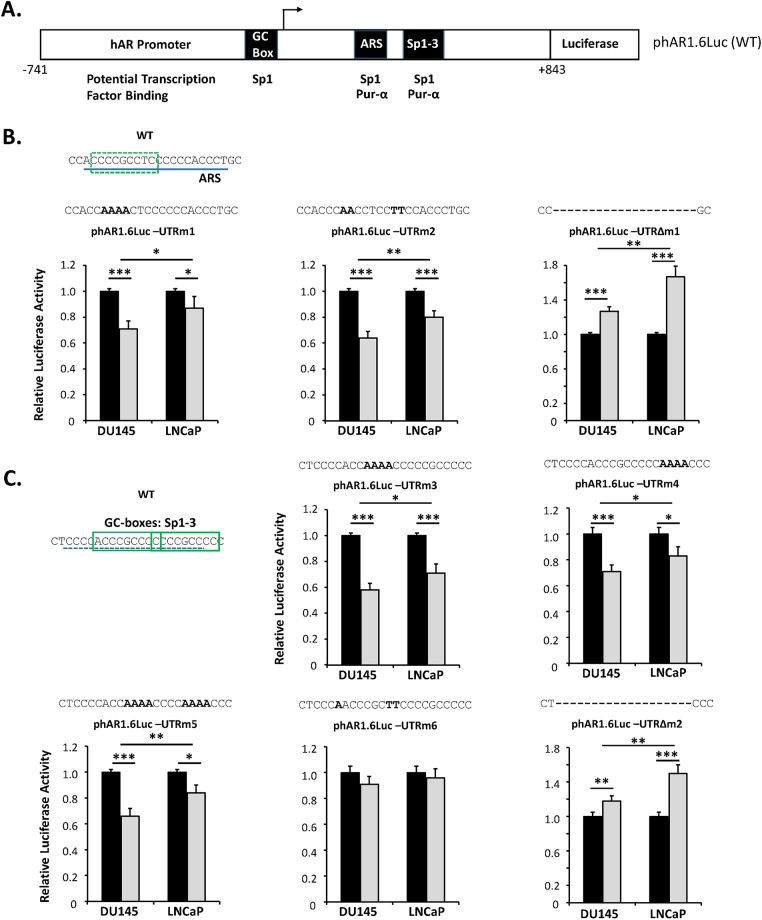
Effect of mutations on transcriptional activity.(A) Schematic diagram of the luciferase reporter construct phAR1.6Luc driven by 1.6 kbp of the hAR promoter and 5’UTR with potential transcription factor binding to the regions of interest. Sp1-3 contains two Sp1 binding sites. (B and C) The indicated PCa cell lines, cultured in complete medium, were transfected with either phAR1.6Luc containing the WT sequence (black bars) or the mutated version (grey bars) shown above each chart. Luciferase data represent the means ± SEM of at least three independent experiments and the statistical significance of the indicated comparisons are: * p<0.05; ** p<0.01 and *** p<0.001.